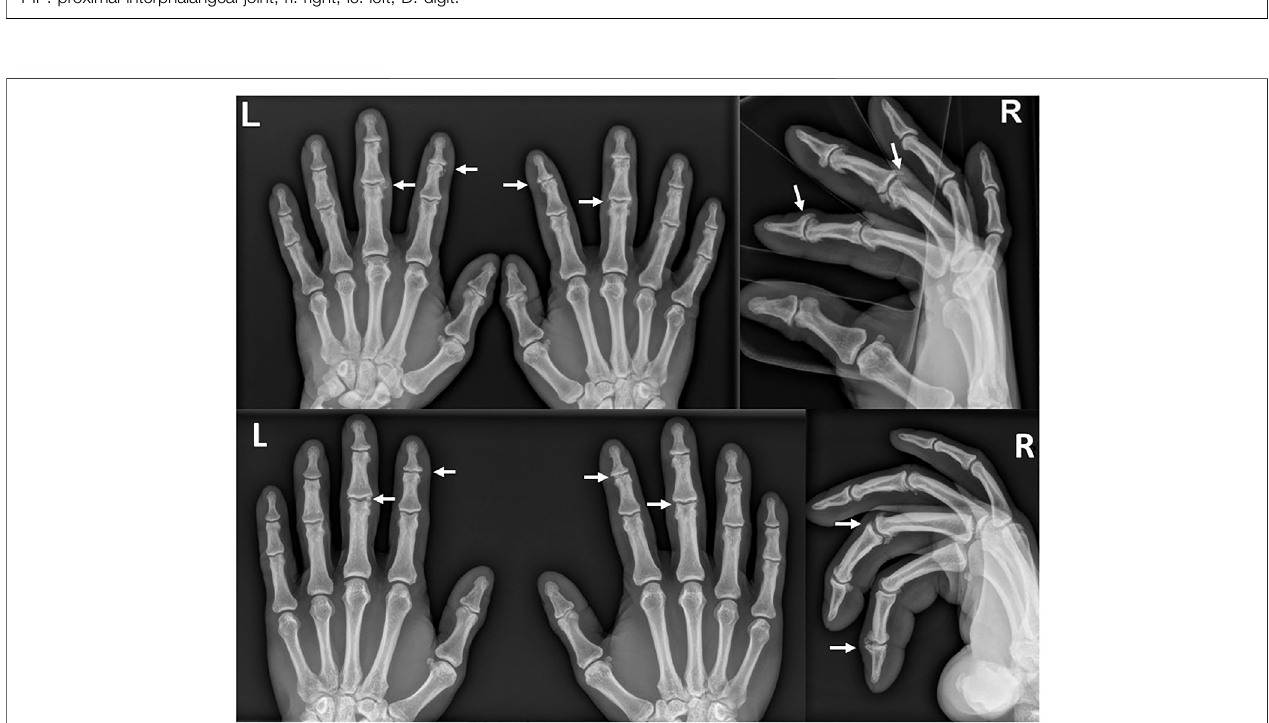
FIGURE 4 | Anteroposterior (left) and lateral (right) radiographs of the same climber: top, current images; bottom, images at baseline 10 years earlier. Note the increasedsignsofosteoarthritiswithlargerosteophytesanddecreasedjointspacesinthecurrentimagesincontrasttothebaselineexamination.Particularlyimpressive fi ndings are marked with arrows as an